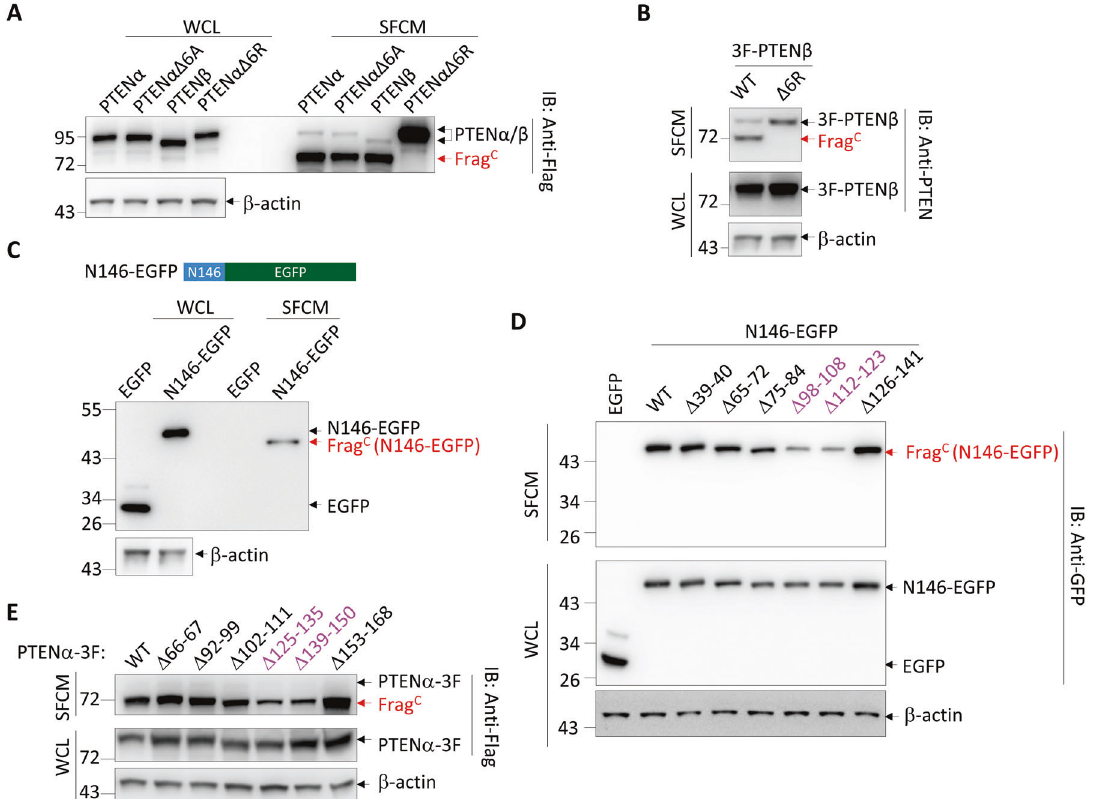
Fig. 4 PTEN α / β are secreted through two elements in their NTEs. A , B Western blot analysis for the indicated proteins in the WCL and SFCM of 293 T cells expressing indicated 3F-PTEN α -3F derivatives or 3F-PTEN β -3F ( A ) and indicated PTEN β derivatives ( B ). C Schematics of N146- EGFP fusion protein (top). Western blot analysis for the indicated proteins with an anti-GFP antibody in 293 T cells expressing EGFP or N146- EGFP (bottom). D Western blot analysis for the indicated proteins in 293 T cells expressing EGFP or N146-EGFP derivatives. E Western blot analysis for the indicated proteins in the WCL and SFCM of 293 T cells expressing indicated PTEN α derivatives. WCL whole-cell lysate, SFCM serum-free conditioned medium, 3 F